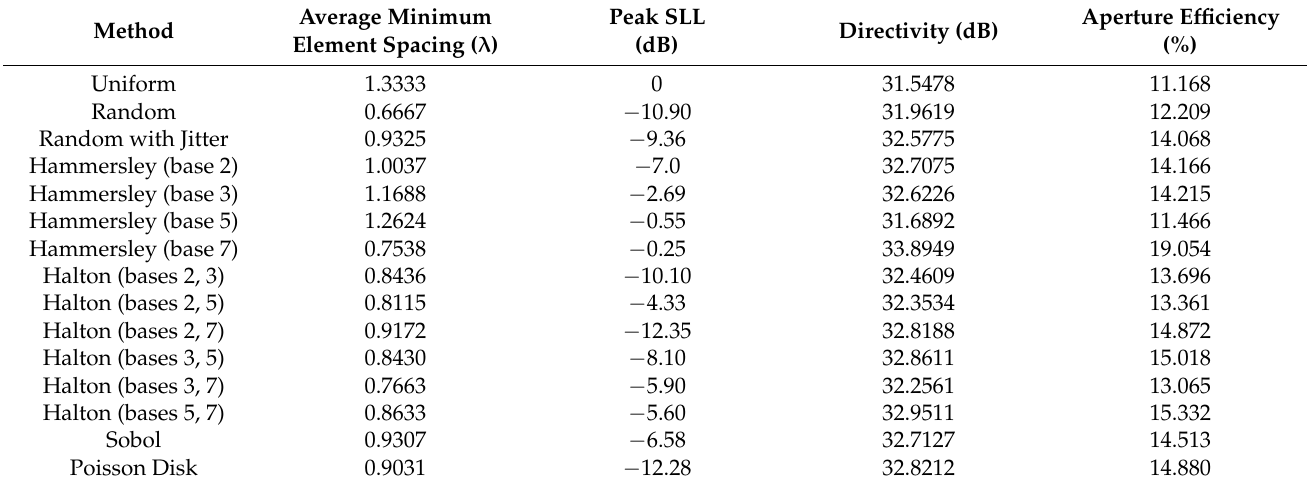
Table 1. Performance metrics for sparse arrays with different element